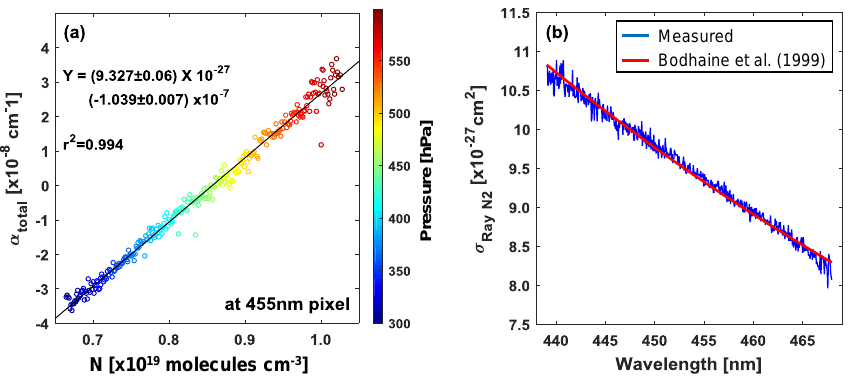
Figure 3. (a) Measured extinction at 455nm vs. number density for a N 2 -filled cavity with varying pressure. The slope represents a Rayleigh scattering cross section ( σ Rayleigh , N2 ) at 455nm of (9.33 ± 0.06) × 10 − 27 cm 2 . (b) Measured wavelength-dependent σ Rayleigh , N2 at 438– 468nm compared to the Rayleigh scattering cross sections reported by Bodhaine et al. (1999).